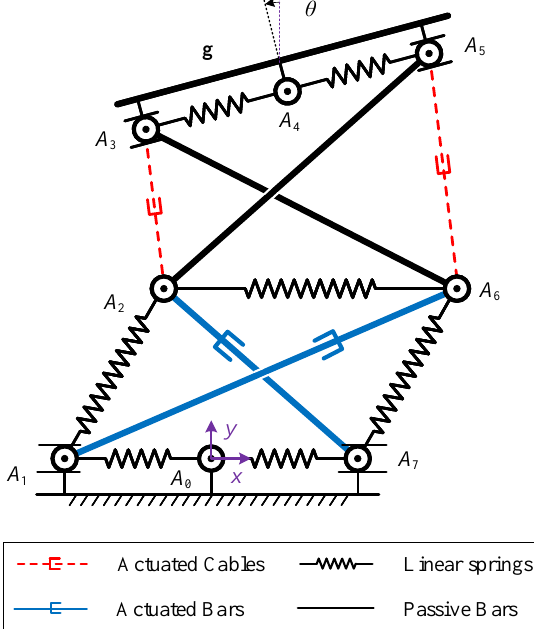
Figure 1. Configuration of the 3-DOF